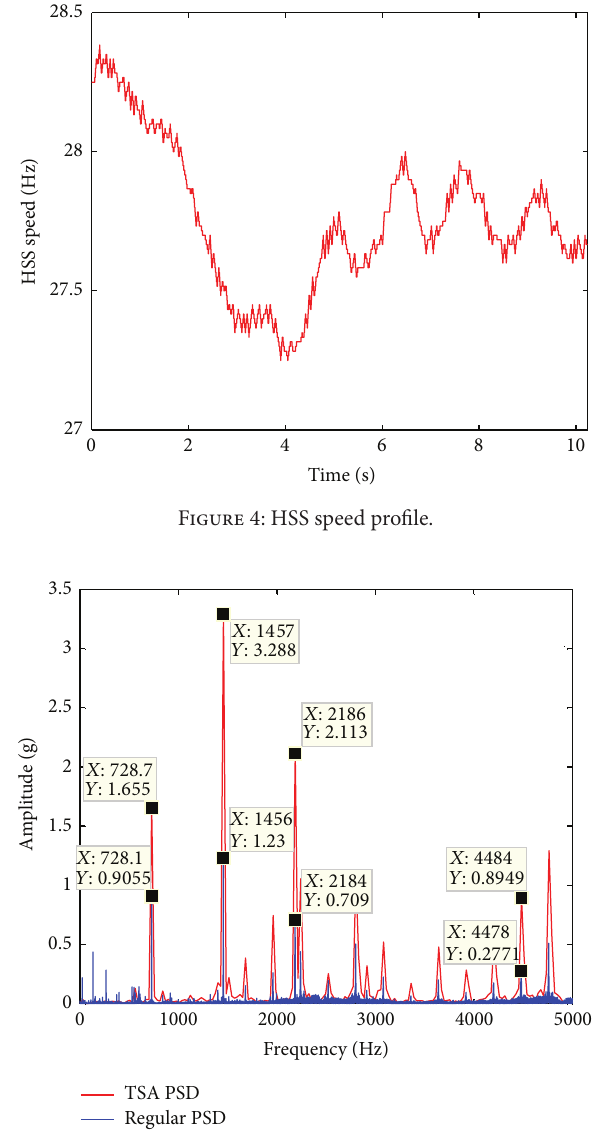
Figure 5: Power spectrum comparison between the regular signal and TSA signal for damaged HSS